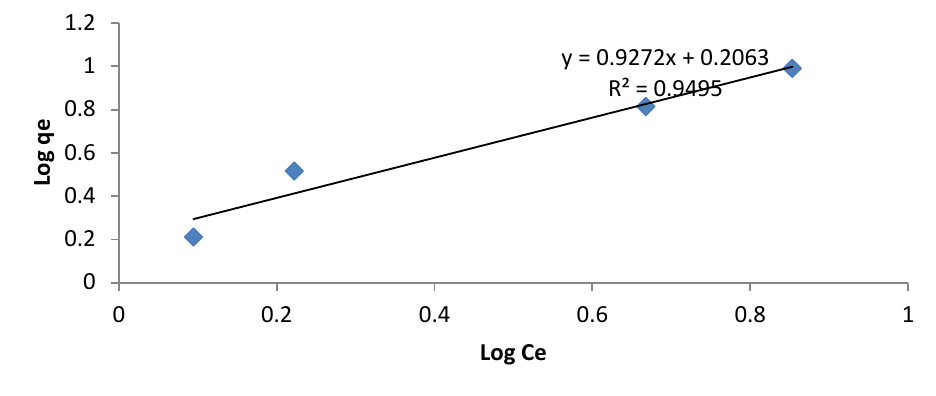
Figure 8: Freundlich isotherm for Cadmium removal by unripe banana peel biomass